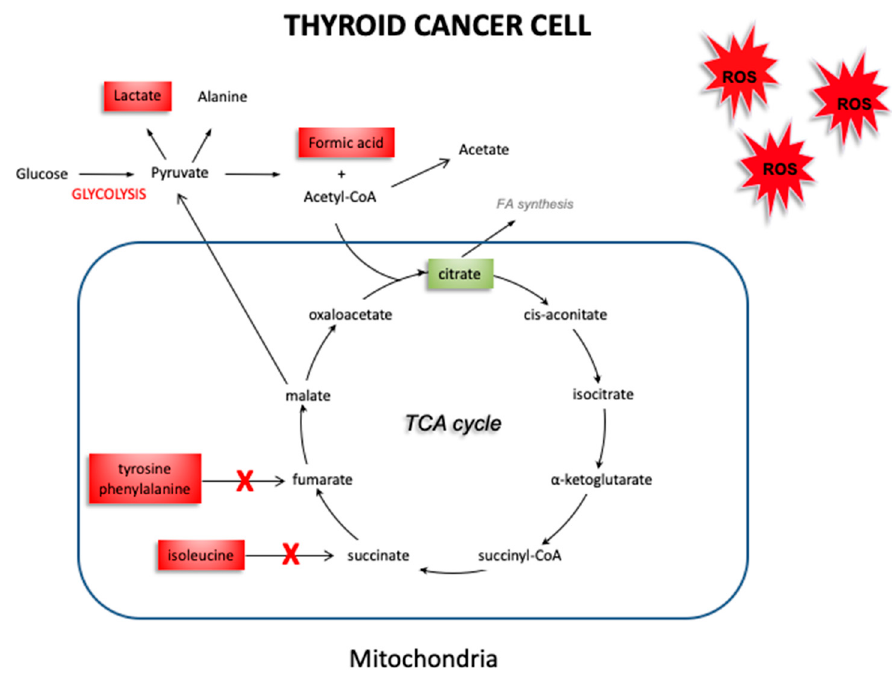
Figure 7. Schematic picture of altered metabolism in thyroid cancer. The reduction observed in the intermediates produced during the Krebs cycle (citrate), along with an accumulation of tyrosine, phenylalanine, isoleucine, acetate and formic acid may be attributable to a decrease in activity of the Krebs cycle, and a shift towards glycolysis in cancer tissue. (The red and green boxes indicate an increase or a decrease of the metabolites’ concentration, respectively).